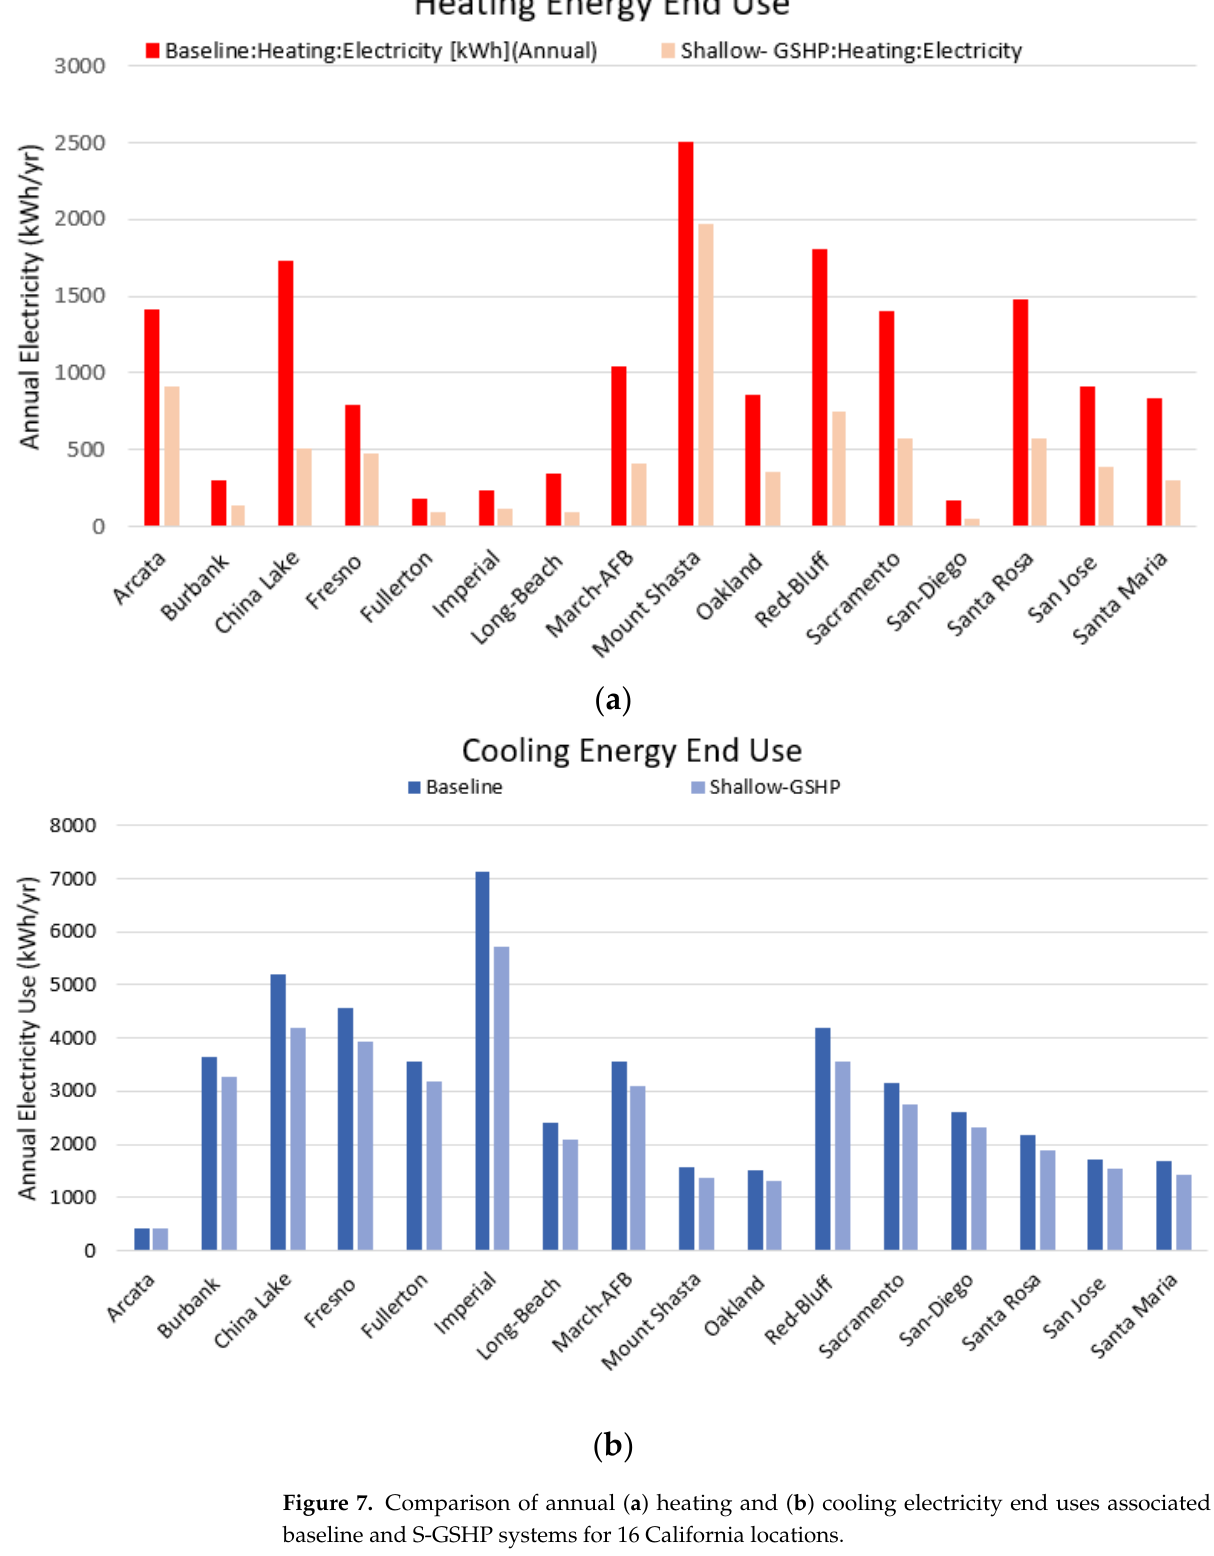
Figure 7. Comparison of annual ( a ) heating and ( b ) cooling electricity end uses associated with baseline and S-GSHP systems for 16 California locations. Table 4. Annual combined heating and cooling energy consumption for both baseline and shallow GSHP systems for all California locations.